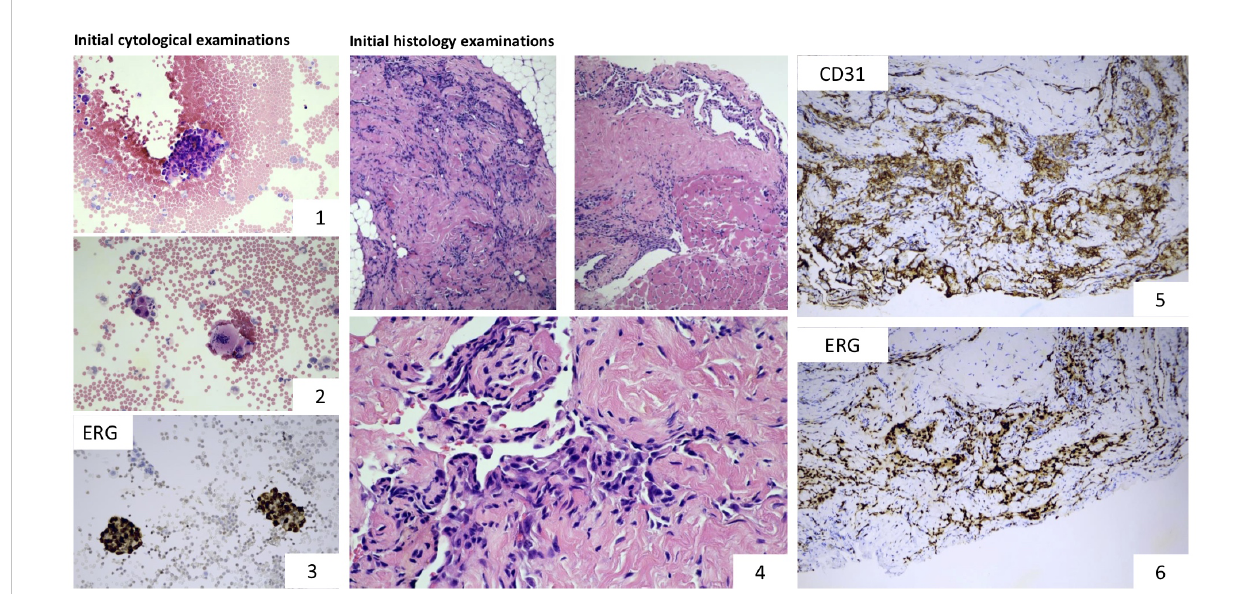
FIGURE 1 Microscopic examinations: Cytological and immunocytochemical examinations performed on the aspirated pleural fl uid show the presence of tumour cells (images 1 and 2) and ERG nuclear positivity (image 3). Characteristic histological features of angiosarcoma: proliferating atypical tumour cells forming anastomosing vascular channels. The lining endothelial cells display marked atypia (image 4). Tumour cells showed strong cytoplasmic CD31 and nuclear ERG positivity (images 5 and 6). Based on the morphology and the immunophenotype, the lesion corresponded with the diagnosis of angiosarcoma, grade